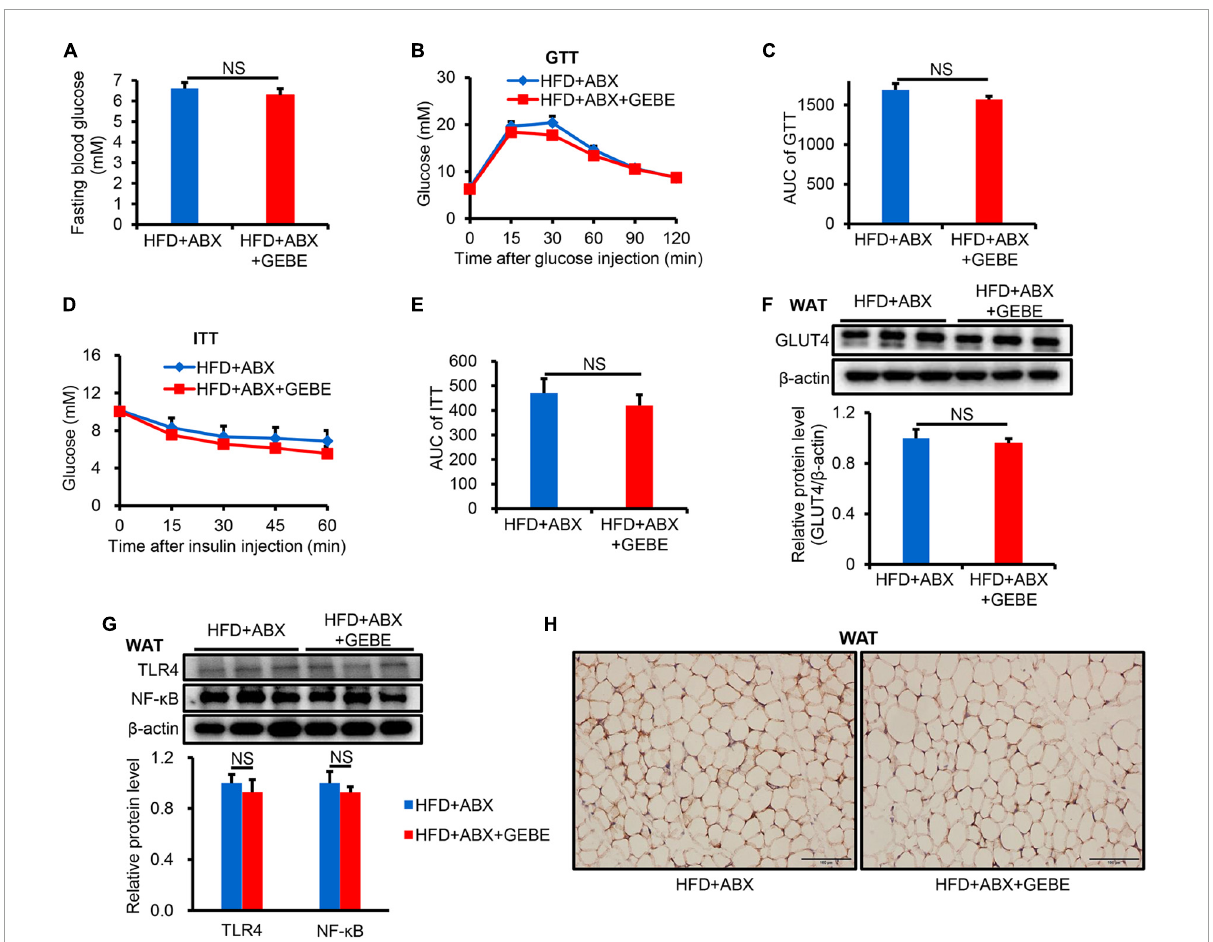
FIGURE3 ABX treatment eliminates the beneficial effects of GEBE on HFD-induced C57BL/6 mice ( n = 8–10). (A) Fasting blood glucose. (B,C) GTT and the AUC for the GTT. (D,E) ITT and the AUC for the ITT. (F) The protein levels of GLUT4 in WAT were measured by western blotting. (G) ABX eliminates the inhibitory effect of GEBE on the expression of inflammation-associated proteins in WAT. (H) Immunohistochemical staining for GLUT4 in WAT. Magnification is 200 × , Scale bar = 100 µ m. NS, not statistically significant. The results are presented as mean ± SEM. HFD + ABX: High-fat diet and water with combined antibiotics; HFD + ABX + GEBE: High-fat diet with GEBE, and water with combined